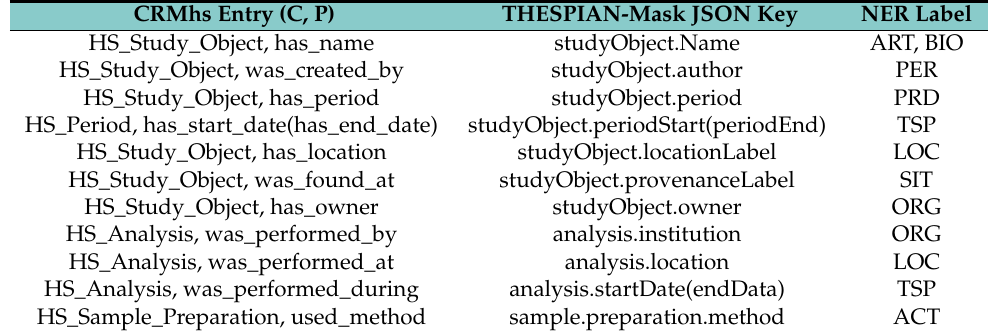
Table 4. Map between CRMhs ontology classes and properties (C, P) and ArcheoNER labels.